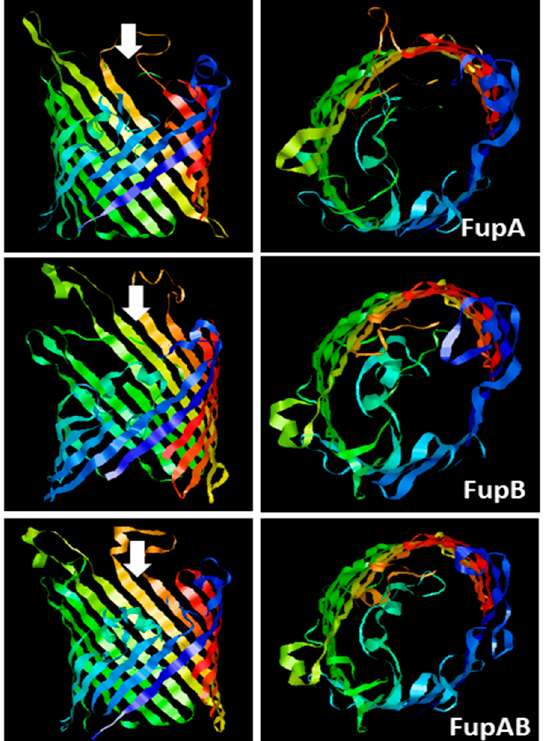
Figure 1. Predicted 3D structures of F. tularensis FupA, FupB, and FupA/B monomers. The C terminal regions of the 3 proteins (310 amino acids from C terminal part of FupA; 304 amino acids C terminal part of FupA/B and FupB) were analyzed using the Phyre2 server. The panels on the left show a lateral view of each transmembrane region constituted of 16-barrels, while the panels on the right show a top view of each transmembrane region, observed from the intracellular compartment and in the direction of the white arrows.